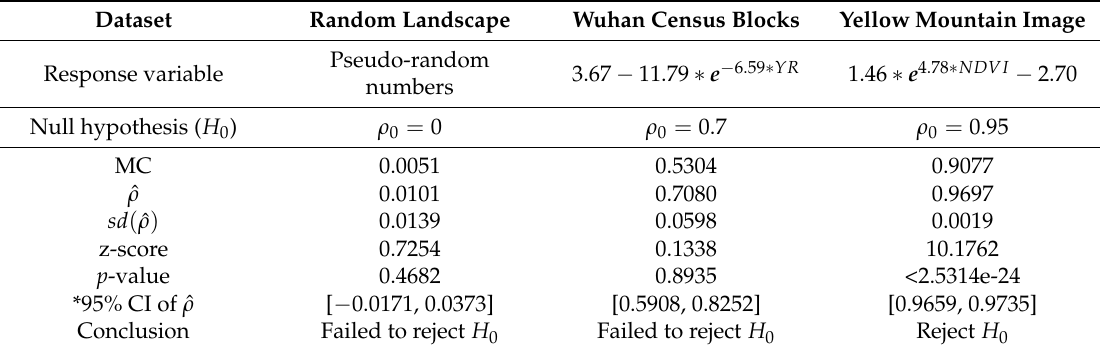
Table 5. Results of zero, moderate, and strong positive spatial autocorrelation (SA)